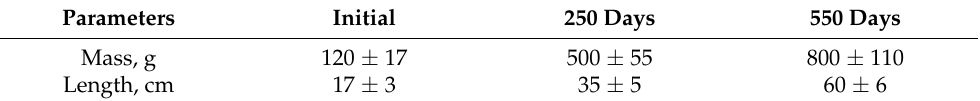
Table 5. Changes in the morphological parameters of the studied carp specimens ( n = 10, p = 0.95). Parameters Initial 250 Days 550 Days Mass, g 120 ± 17 500 ± 55 800 ± 110 Length, cm 17 ± 3 35 ± 5 60 ±